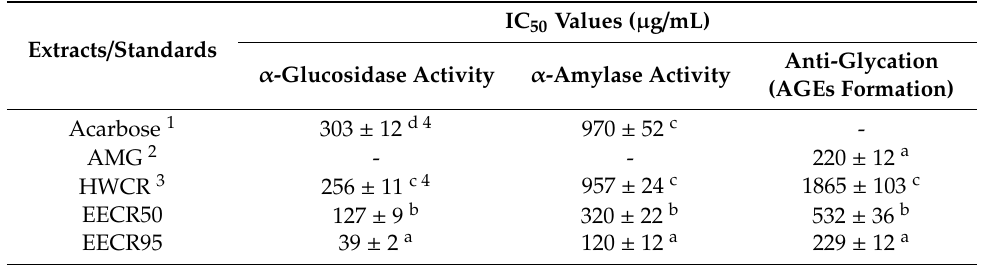
IC 50 Values ( µ g / mL)